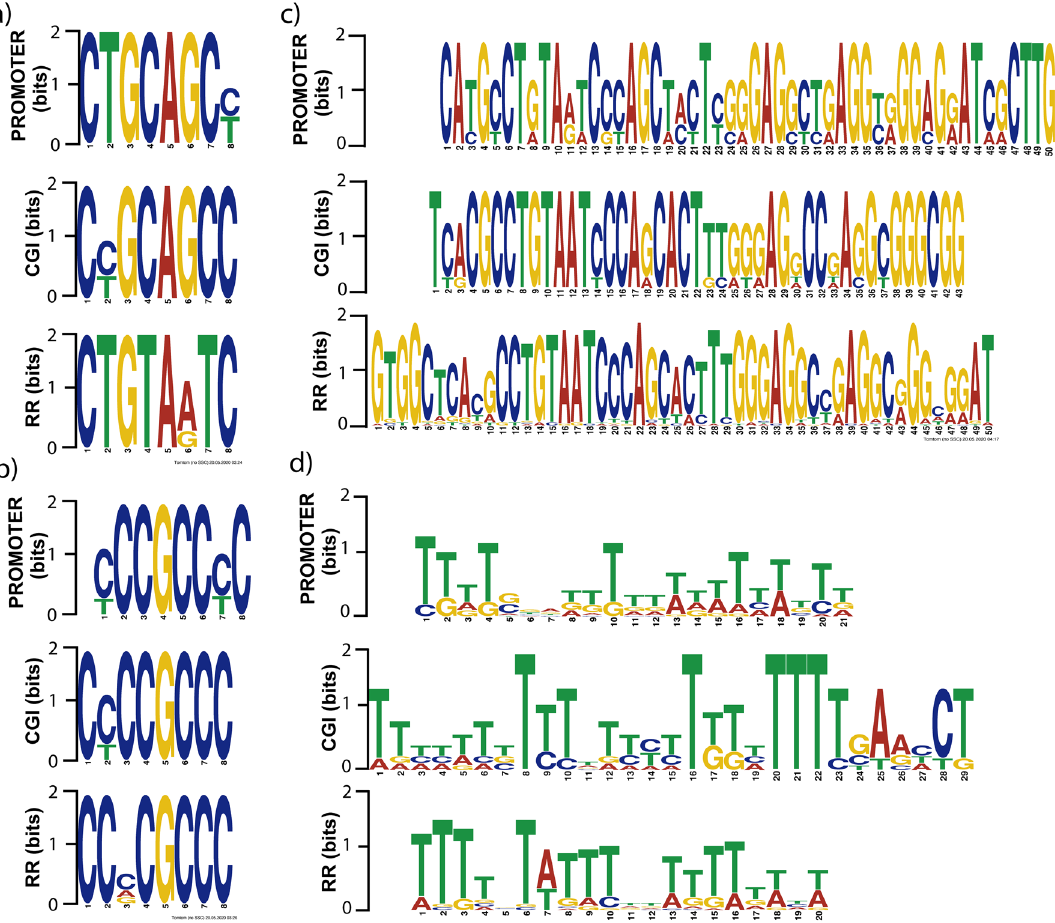
Figure 2. DNMT3B downregulated genes have common motifs in their functional regulatory regions. Common sequences found with MEME Suite in P-down-3B genes. ( a ) and ( b ) short and ungapped motifs determinate with DREME in RR, CGI, and PROMOTER. ( c ) The top De Novo motif found with MEME. ( d ) The top motif discovered with MEME ChIP (Human-Methylcytosine, Yan 2017) in the three functional regions from